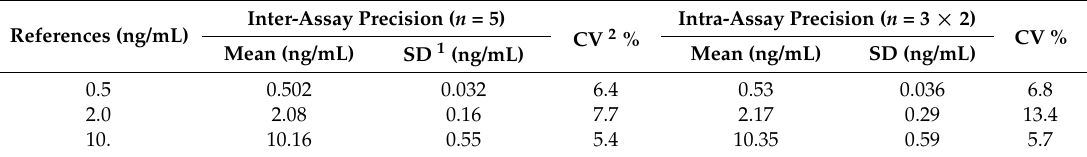
Table 2. Precision results of the CM-EU test strips.